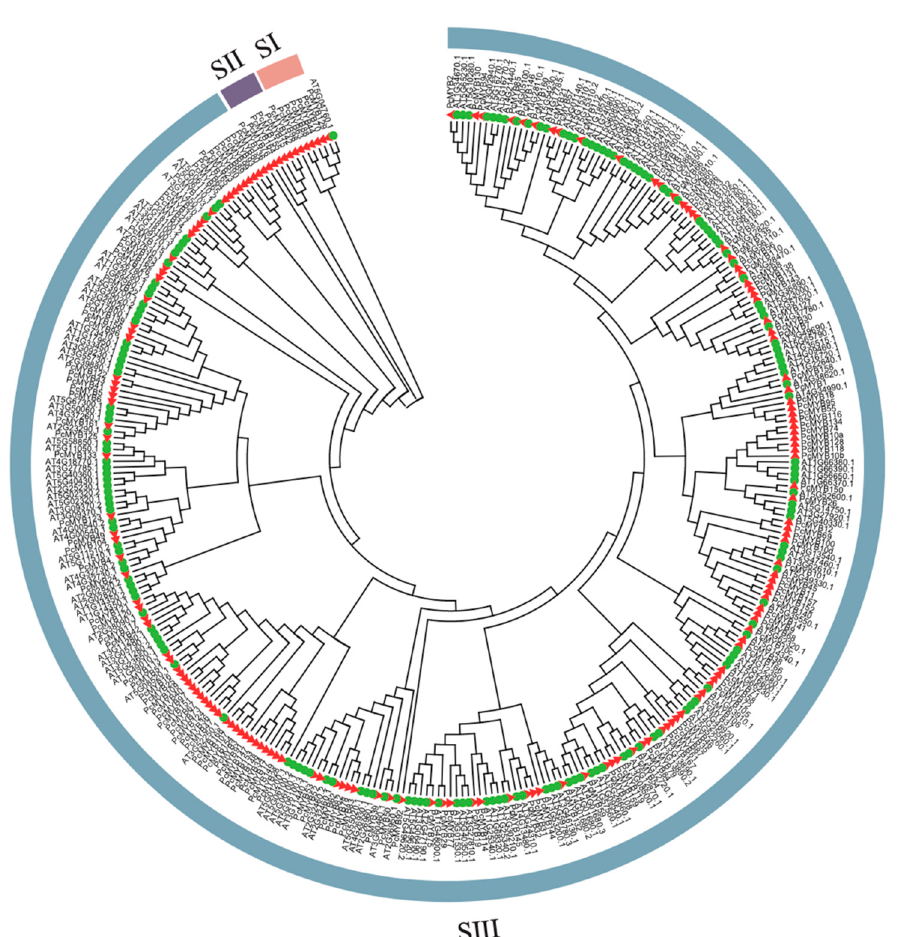
Figure 7. Phylogenetic relationships of the MYB proteins from P. campanulata and A. thaliana . The red triangle denotes the protein from P. campanulata , and the green circle denotes the protein from A. thaliana .